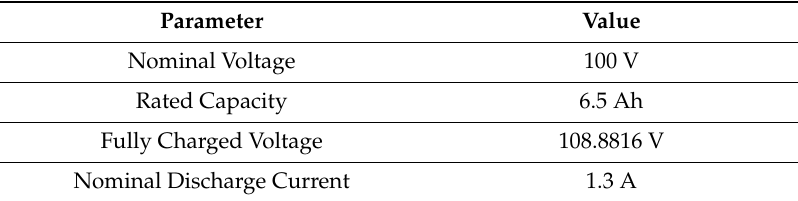
Table 1. Parameters of the battery in the ESS.